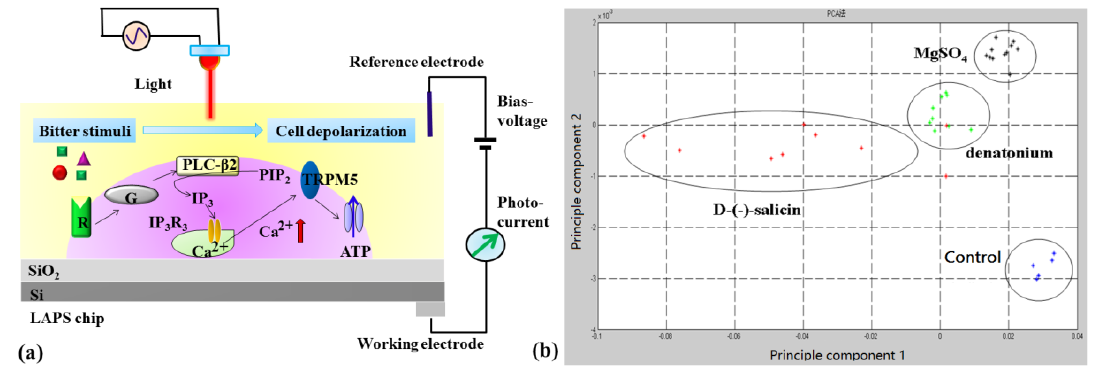
Figure 4. ( a ) Schematics of LAPS cultured with taste receptor cells for the detection of specific bitter substances; ( b ) Principal component analysis (PCA) results indicate that different bitter